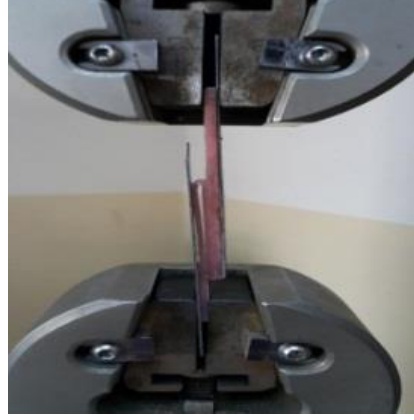
Figure 6: Peel bond specimen under testing.